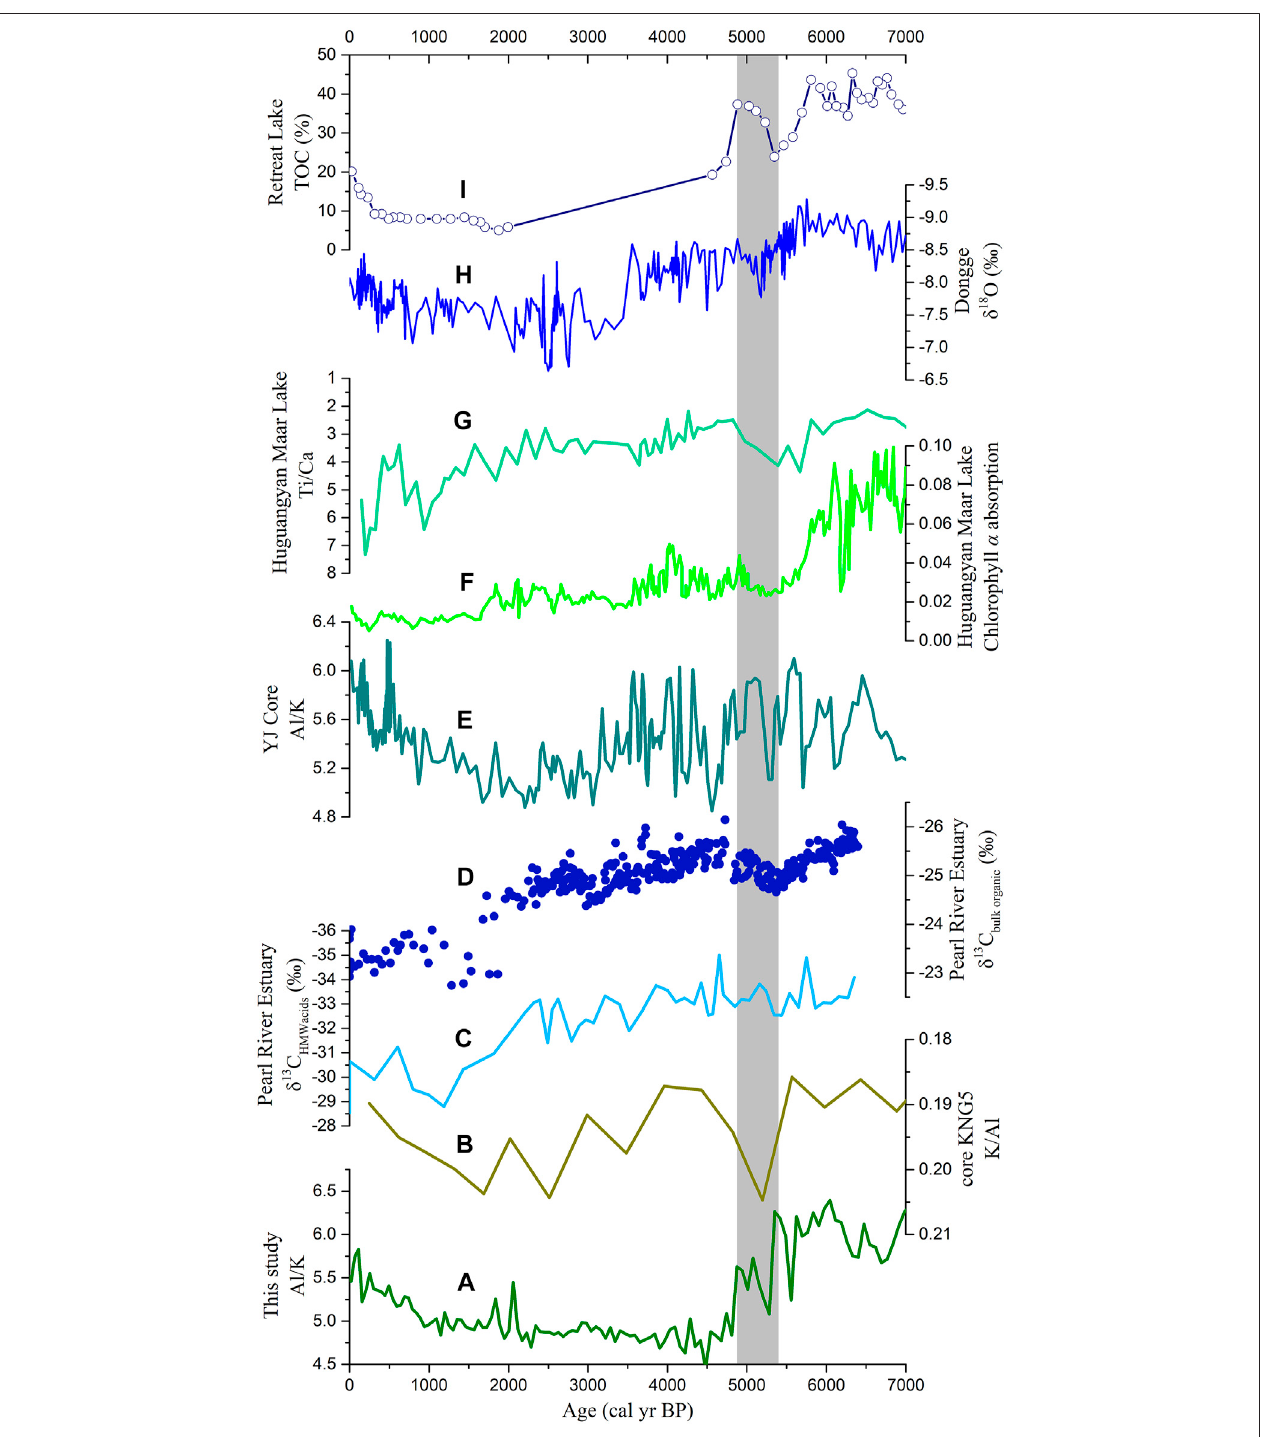
FIGURE 4 | Comparisons between related records: (A) Al/K ratios from our GH6 core; (B) K/Al record from the northern South China Sea slope (Huang et al., 2016); (C) compound-speci fi c δ 13 C record from the Pearl River Estuary (Strong et al., 2013); (D) δ 13 C org record from the Pearl River Estuary (Yu et al., 2012); (E) Al/K ratios from the northern inner shelf of the South China Sea (Huang et al., 2019); (F) chlorophyll- α record from Huguangyan Maar Lake (Wu et al., 2012); (G) Ti/Ca record from Huguangyan Maar Lake (Shen et al., 2013); (H) stalagmite δ 18 O record from Dongge Cave (Dykoski et al., 2005); and (I) TOC data from Retreat Lake in northeastern Taiwan (Selvaraj et al., 2007).